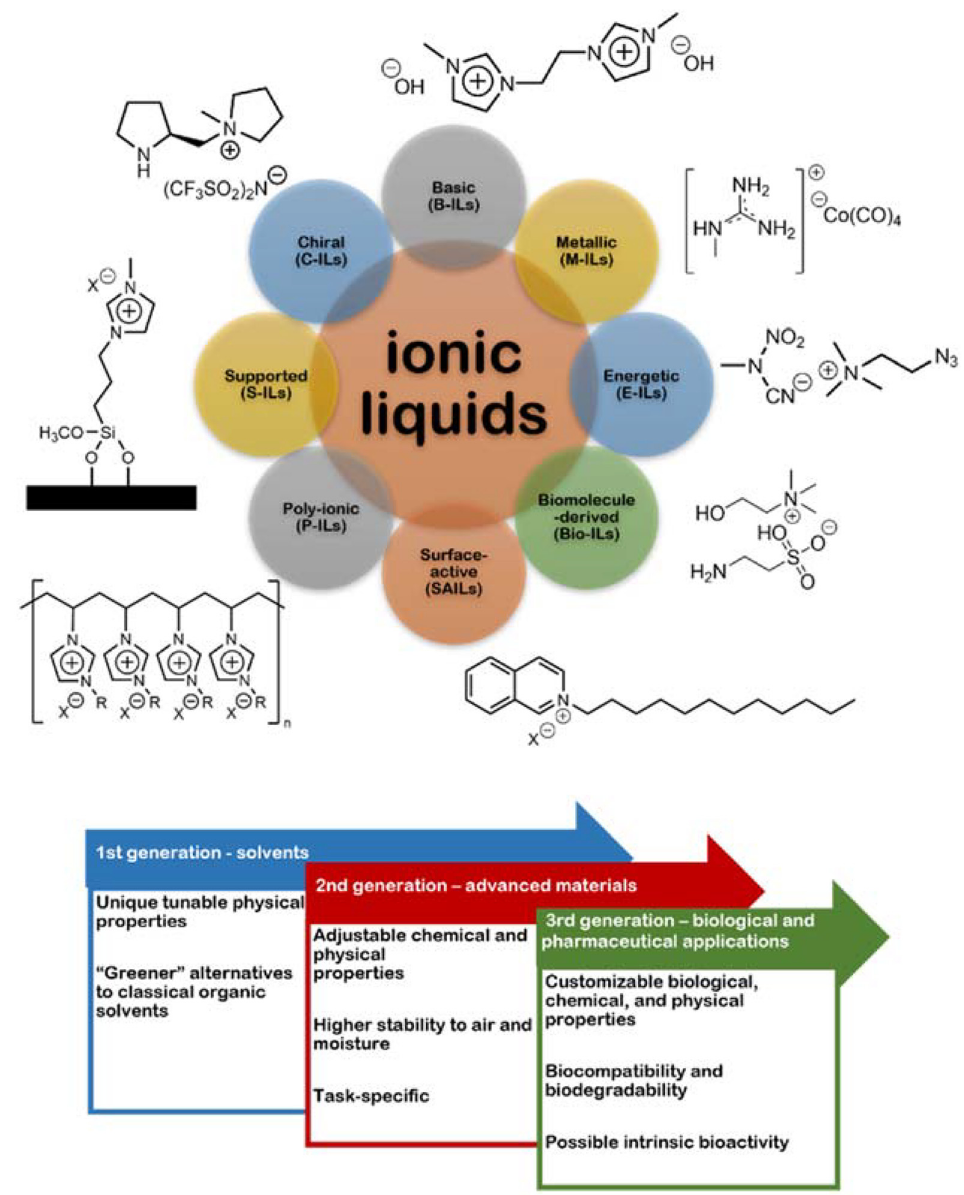
Figure 2. Examples of ionic liquids (ILs) from different generations, along with their properties and uses. Adapted from Gomes et al. [13] . Copyright 2021—MDPI, under Creative Commons Attribution license.